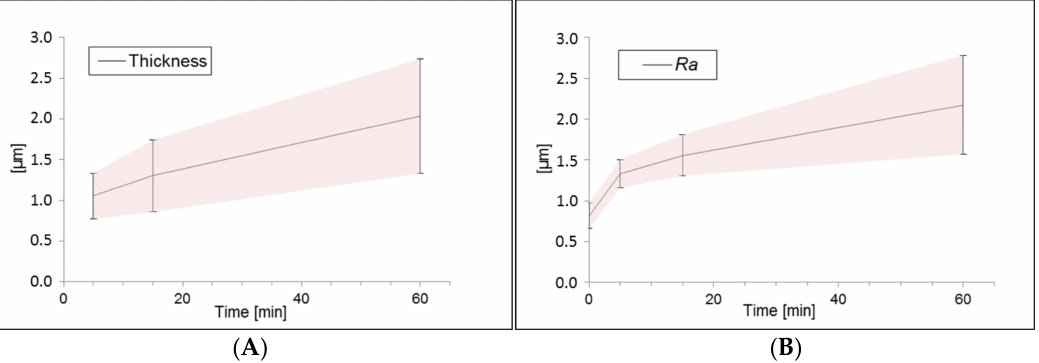
Figure 8. ( A ) Thickness measurements that were obtained by profilometry; ( B ) average roughness of the